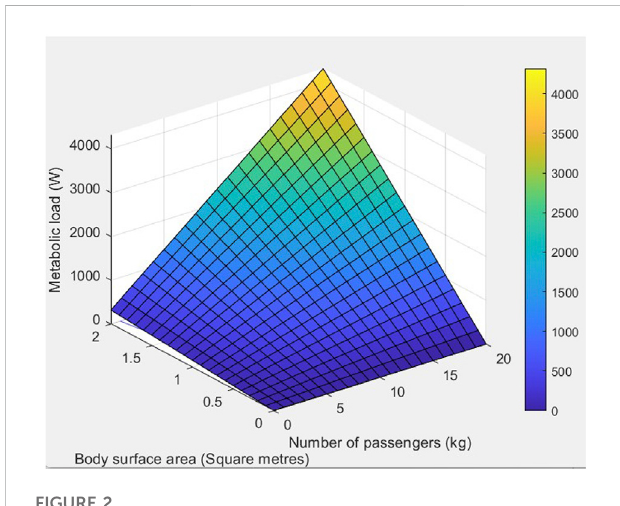
FIGURE 2 Metabolic heat load distribution vs. body surface area (m 2 ) and number of passengers.